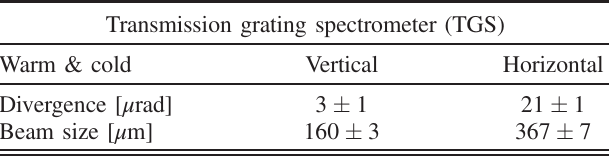
TABLE III. Electron beam parameters during the TGS mea- surements deduced from a wire scan at the undulator position. Transmission grating spectrometer (TGS) Warm & cold